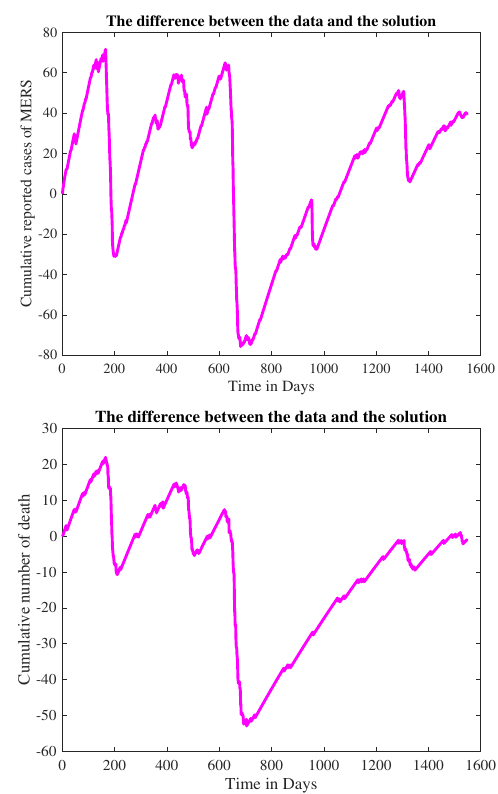
Fig. 11: Riyadh: The difference between the data and the